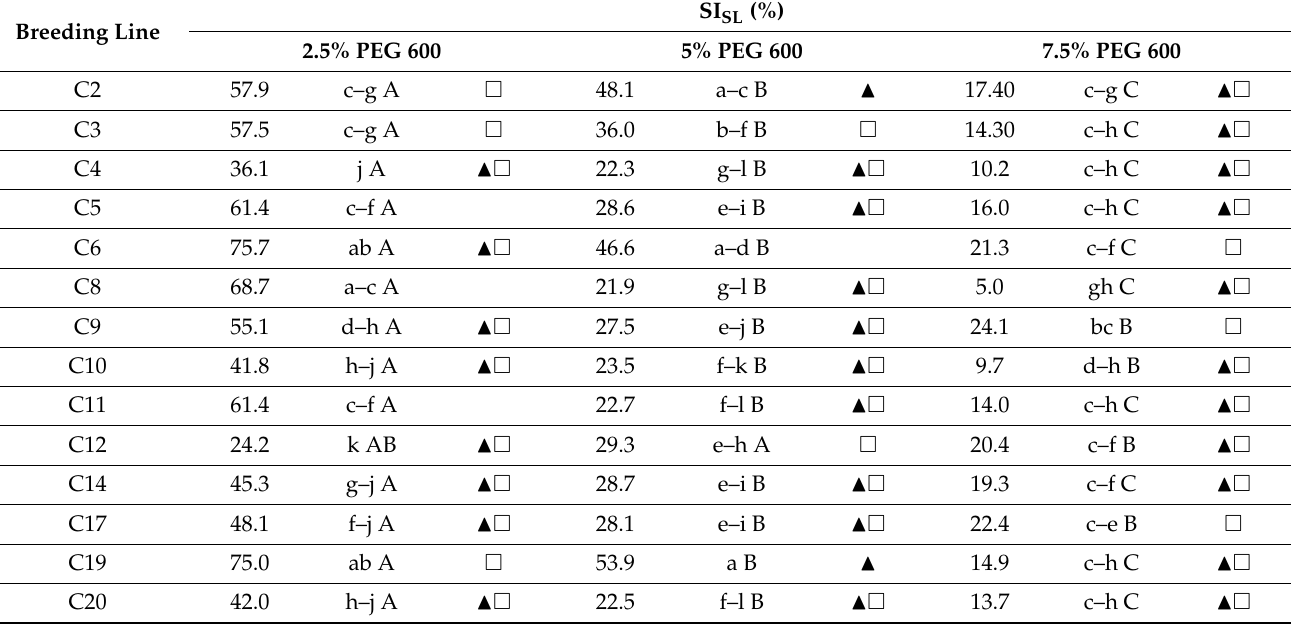
Table 7. Shoot length SI (SI SL ) values of potato genotypes under stress treatment induced by PEG 600 added to the medium at levels of 2.5%, 5.0% and